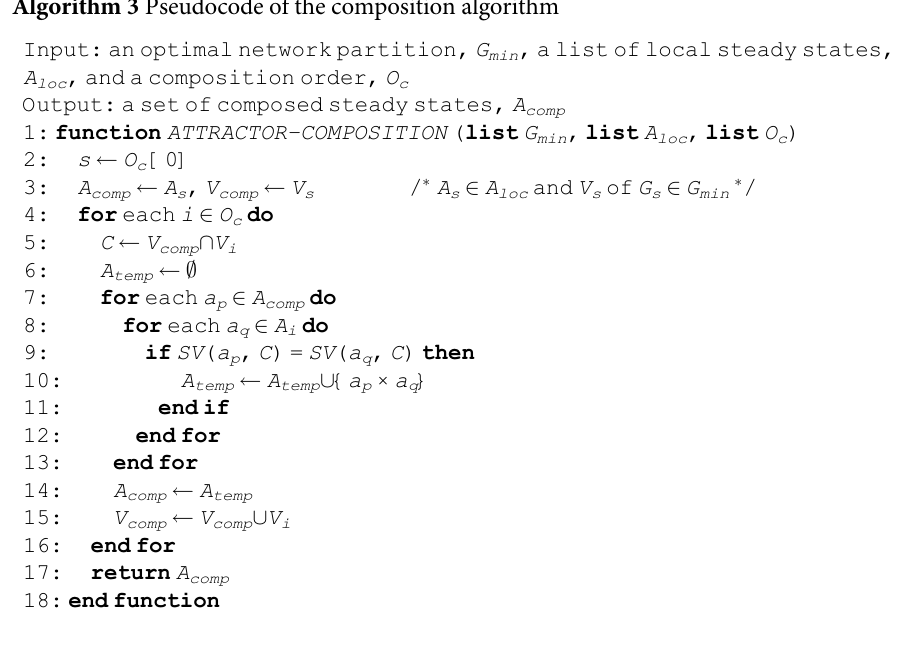
Algorithm 3 Pseudocode of the composition